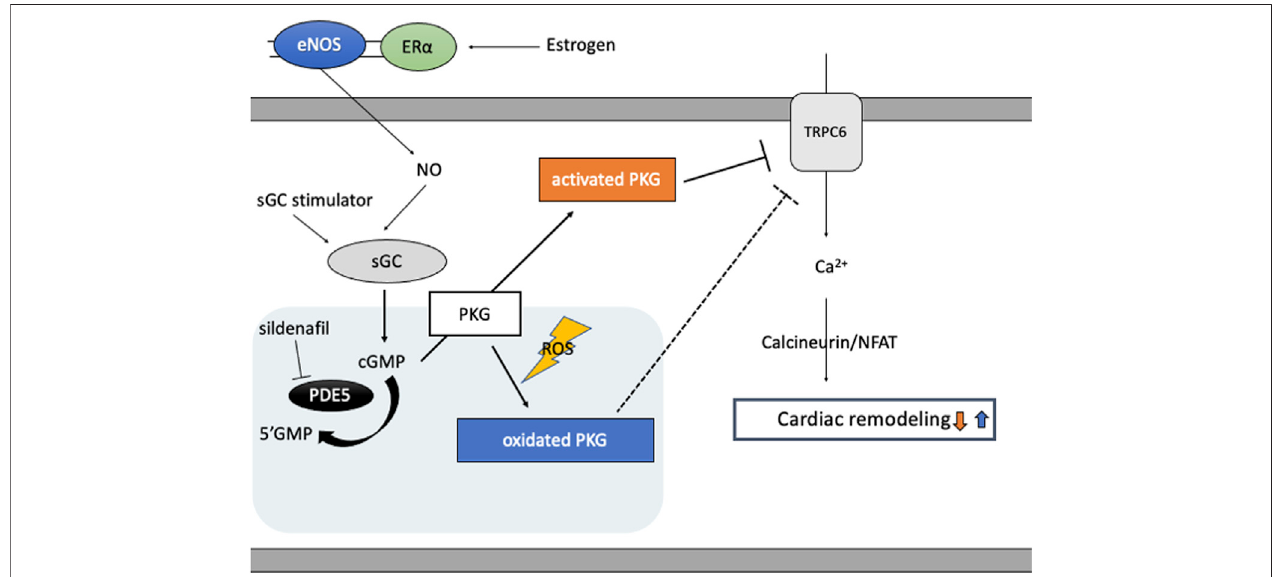
FIGURE 2 | cGMP/PKG signaling and PKG oxidation. Estrogen plays a pivotal role in cGMP-PKG signaling coupled with eNOS via estrogen receptor (ER ɑ )- mediated non-nuclear signaling. In diseased conditions like heart failure, eNOS activity is impaired and PKG undertakes oxidation and localizes in cytosol, inhibiting protective effects of PKG signaling independent of cGMP and enhancing cardiac remodeling via target proteins like TRPC6. PDE5 inhibitor, sildena fi l, reveals protective effects only under the condition of suf fi cient oxidated PKG1 α , while sGC stimulator improves cardiac remodeling independent of PKG redox status.